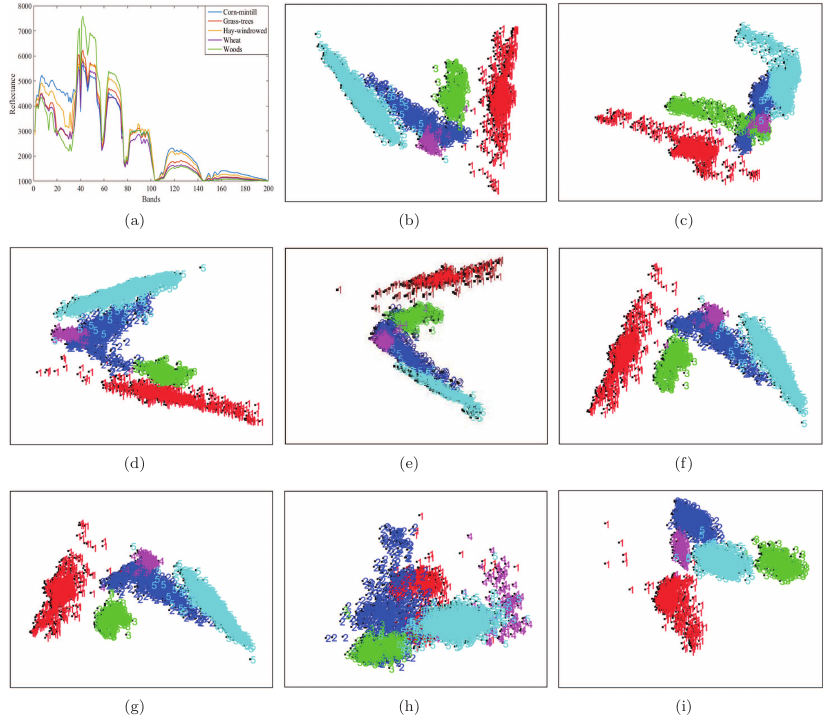
Figure 7. Two-dimension embedding of different DR methods on the Indian Pines data set. ( a ) Spectral signatures; ( b ) PCA; ( c ) NPE; ( d ) LPP; ( e ) SDE; ( f ) LFDA; ( g ) MMC; ( h ) MFA; ( i )